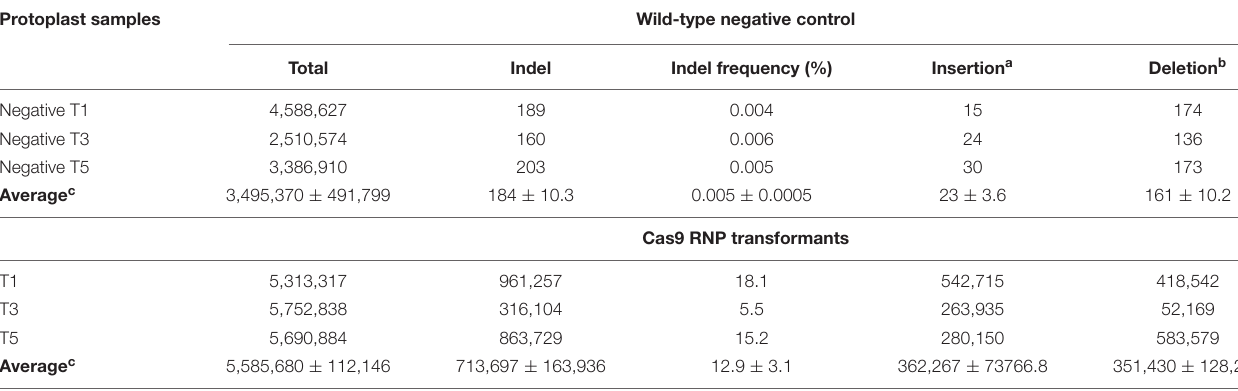
TABLE 1 | Estimation of mutation rate in GmCPR5 gene sequences in wild-type non-transformed and transformed protoplasts by targeted deep sequencing in soybean protoplasts using direct delivery of RNP’s. Protoplast